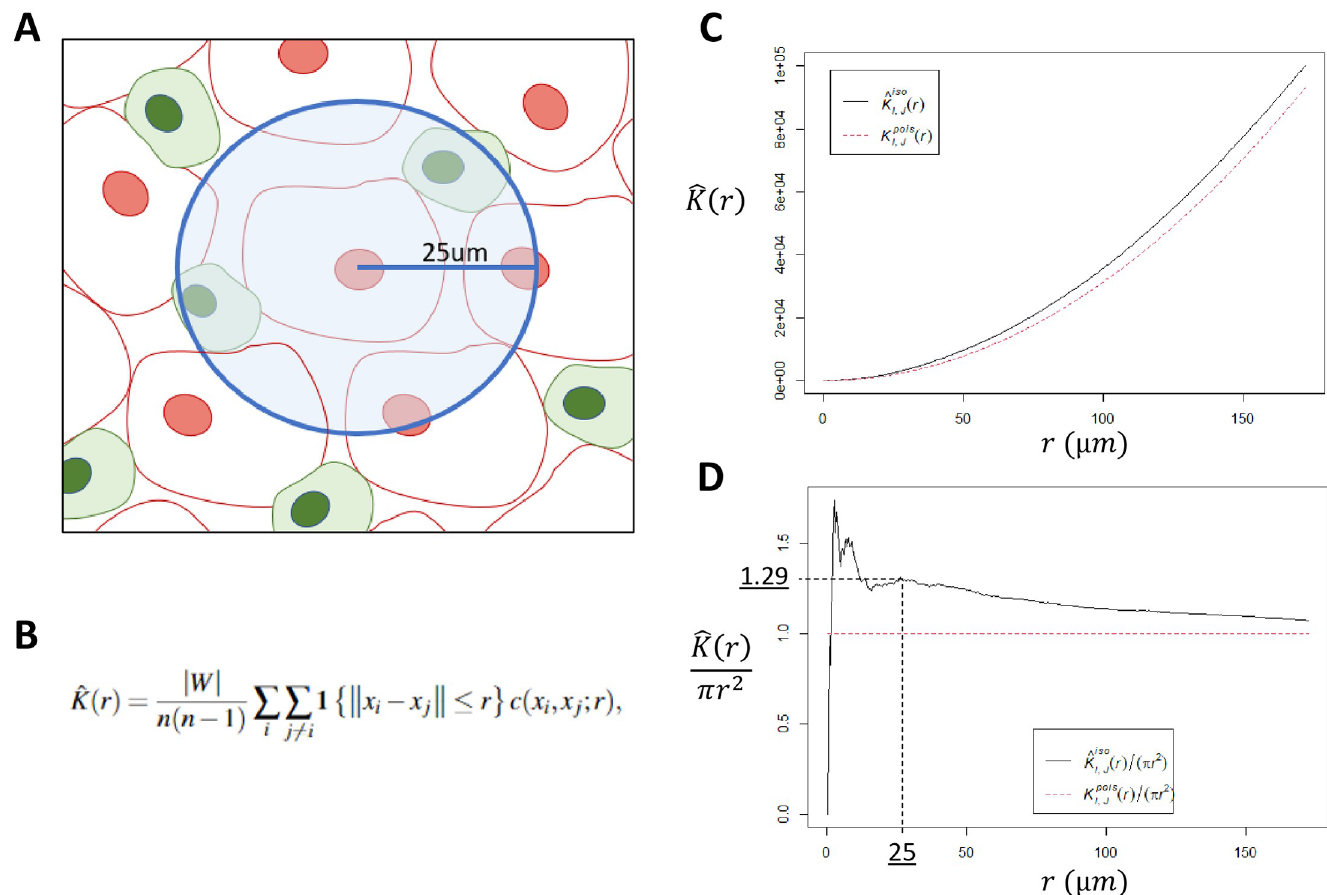
Fig 1. Ripley’s K function. A: Illustrative representation of the pairwise Ripley’s K function, where the number of cells of interest is identified within a search radius from another cell type, repeating the process over a continuum of radii, for each cell in the study area. B: The Ripley’s K function estimator, where n is the total number of points in the study area, W is the study area, 1{| xi-xj |} � r } is an indicator worth a value of 1 if points i and j are within distance r , and c(xi , xj;r) represents the applied edge correction (this analysis utilized isotropic edge correction). C: Plot of the na ï ve K(r) function using a representative slide from our analysis. The black solid line is the observed K(r), and dotted red line is the expected distribution if cells were randomly distributed, assuming a Poisson distribution. D: Normalization of the na ï ve Ripley’s K function into K(r)/ π r 2 , resulting in an expected distribution of 1 for all values of r . The search radius utilized in this analysis was 25um. In this manuscript, K (25um)/ π r 2 is abbreviated to